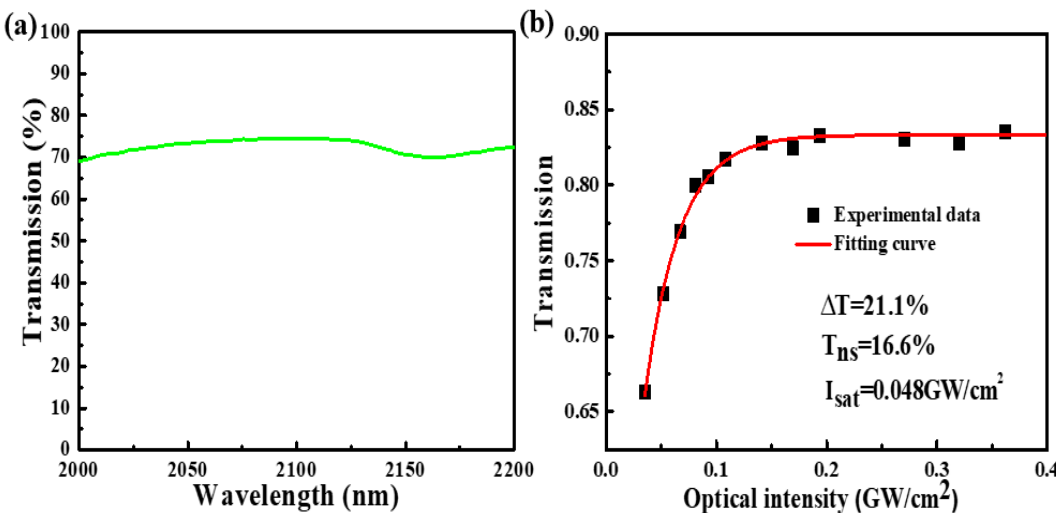
Figure 2. ( a ) Transmission spectrum, ( b ) nonlinear transmission curve.